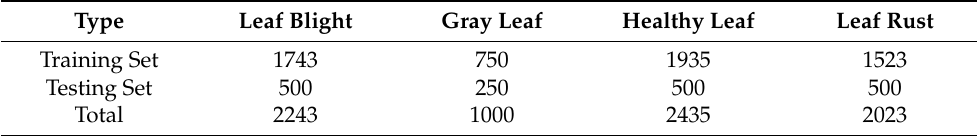
Table 1. Distribution details of the maize disease dataset.